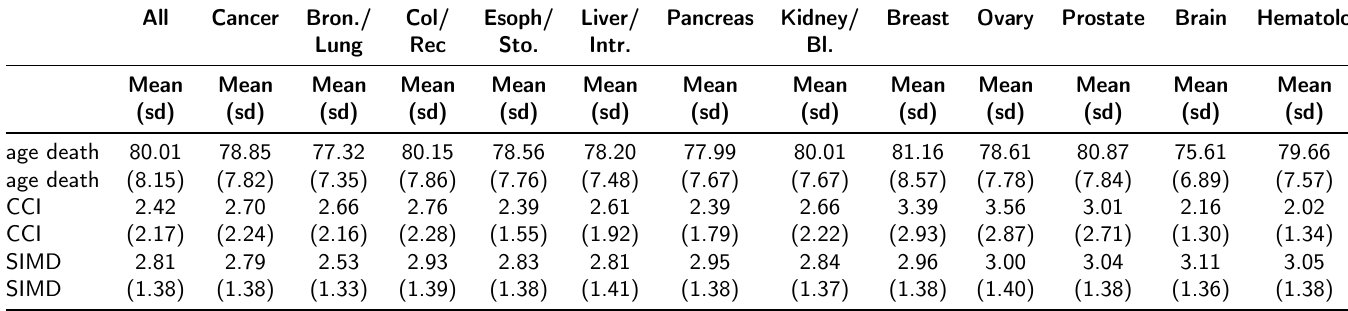
Table 2: Average age at death, comorbidity burden (measured using the Charlson Comorbidity Index [CCI]) and socioeconomic status (measured using the Scottish Index of Multiple Deprivation [SIMD]) of Scottish decedents (2012 to 2017) with a cancer diagnosis presented by cancer type